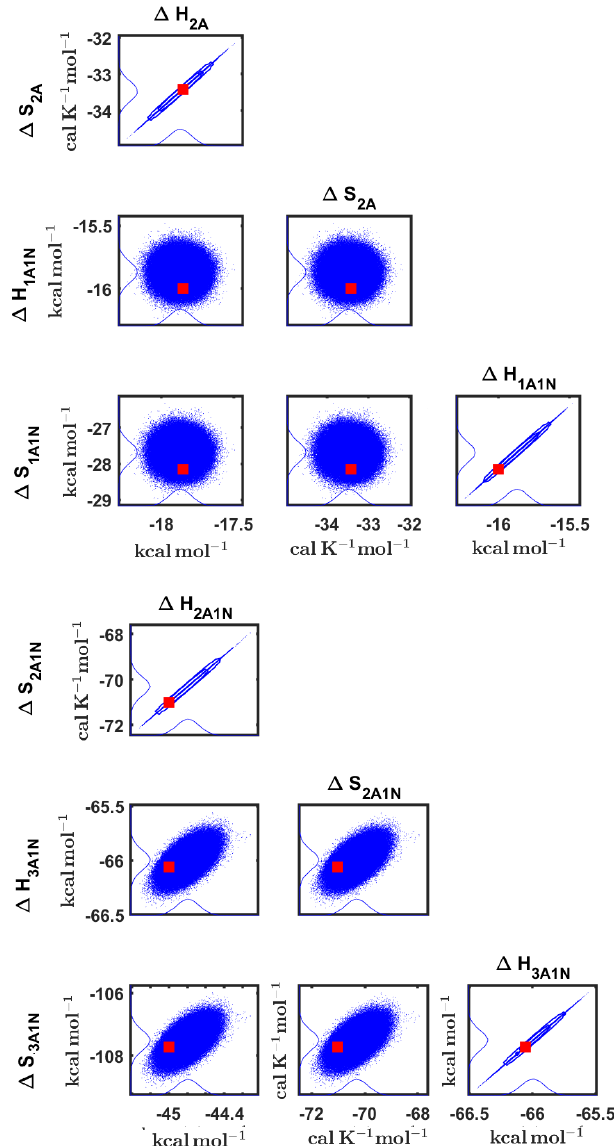
Figure 8. Pairwise marginal posterior distributions (for parameter indexes ranging from 1 to 8) of the cluster formation enthalpies and entropies determined from steady-state cluster concentration mea- surements at two temperatures ( T = 278K and T = 292K). Red rectangles denote the baseline values from Olenius et al. (2013b) used to generate the synthetic data. Here, the symbols (cid:49) H and (cid:49) S stand for cluster formation enthalpies and entropies, respectively. The notation xAyN corresponds to a cluster with x sulfuric acid and y ammonia